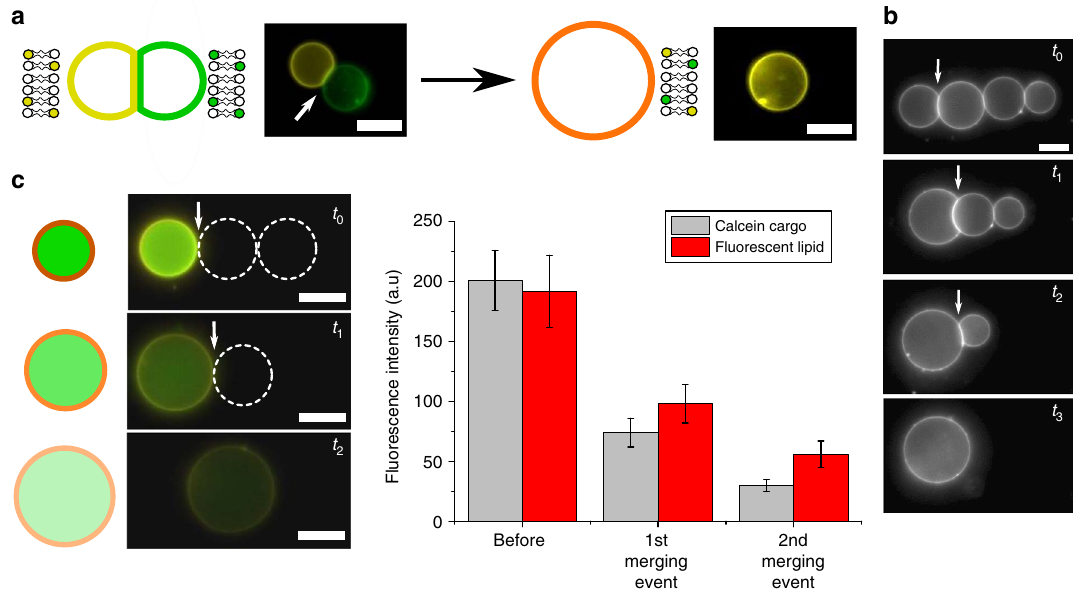
Fig. 8 Vesicle network fusion and material mixing. a Schematic and fl uorescence images of a Rh-PE (yellow) and NBD-PE (green)-labelled vesicle fused to yield a larger vesicle containing both lipids. b A four-vesicle network where each vesicle junction is ruptured in turn by the laser, demonstrating spatial control of the process. c Dilution of both the cargo (calcein; green) and membrane material (Rh-PE; yellow) of a vesicle through sequential merging with two empty vesicles (dotted white circles). Graph shows mean fl uorescence intensity of cargo and membrane (error bars = 1 s.d.; n = 10). White arrows show the VIM selected to fuse. Scale bars = 5 µ m for all